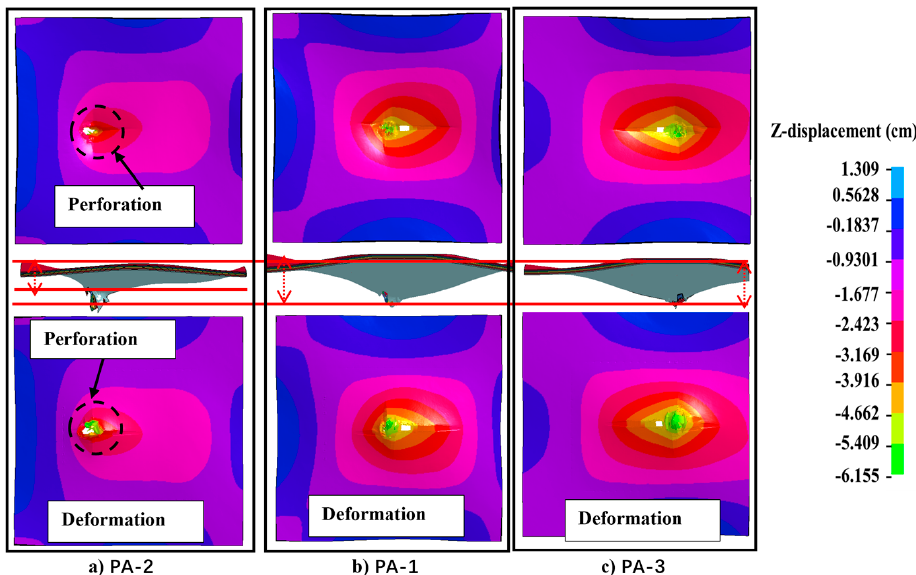
Figure 21. Deformation of UHMWPE laminate during penetration of PA at different hit points PA-2 ( a ), PA-1 ( b ) and PA-3 ( c ).